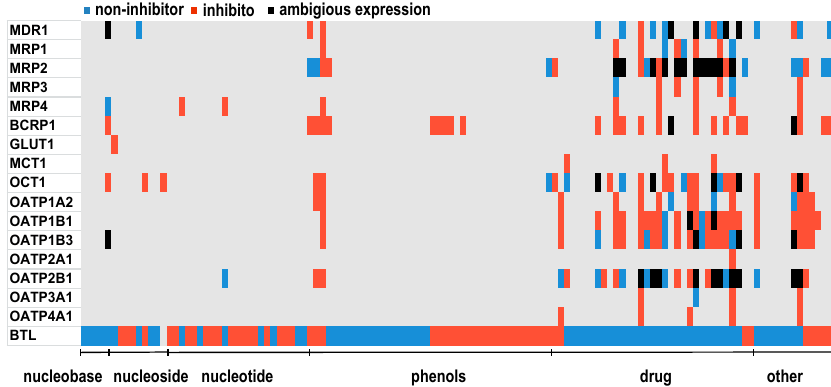
Figure 6. Activity profile for 120 compounds including BTL experimental data [53,54] and data available for 16 transporters in Metrabase [46]. Grey —no data available in database.